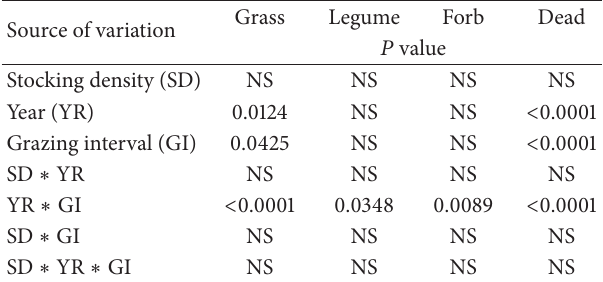
Table 5: Analysis of variance for main components of grassland botanical composition as a function of stocking density, grazing interval, year, and their